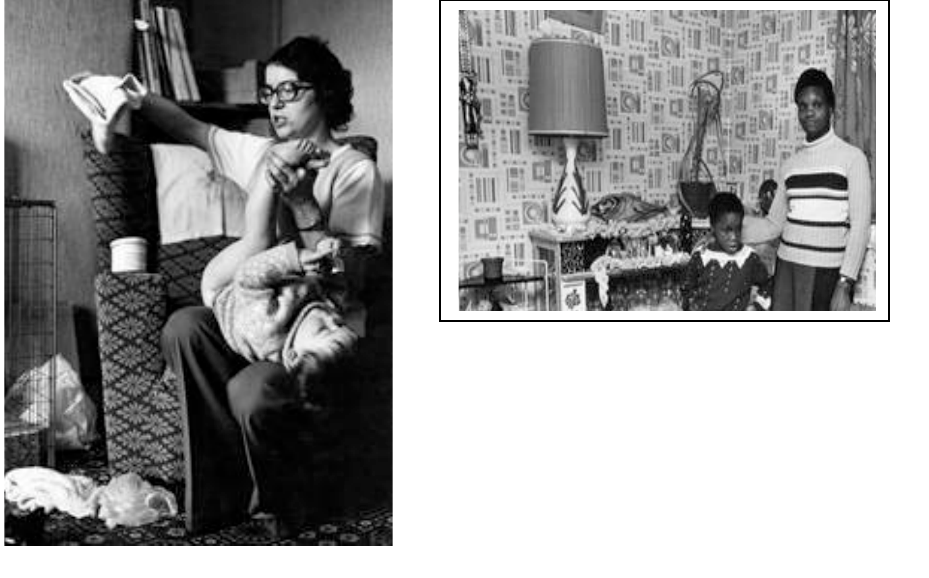
Figure 3: Hackney Flashers 1978, Beyond the Family Album and Other projects Belfast Exposed Archive